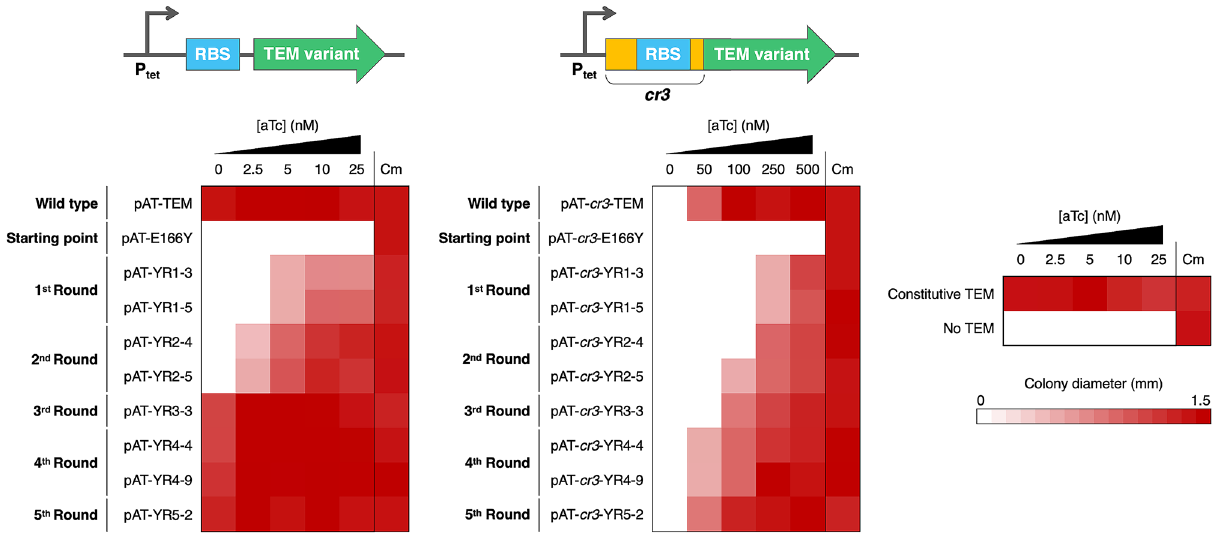
Figure 4. Heat map representing the average colony diameter of E. coli XL1-Blue expressing evolved TEM variants under the control of the pAT and pAT- cr3 vectors. All selected gene variants were subcloned into pAT and pAT- cr3. Each TEM variant-expressing E. coli strain was grown on LB Amp50 containing varying concentrations of aTc and on LB Cm30 at 37 °C for 24 h. E. coli XL1-Blue containing the pAT plasmid was used as the negative control. Colony diameters were determined by ImageJ 25 . The raw data are shown in Tables S5 and